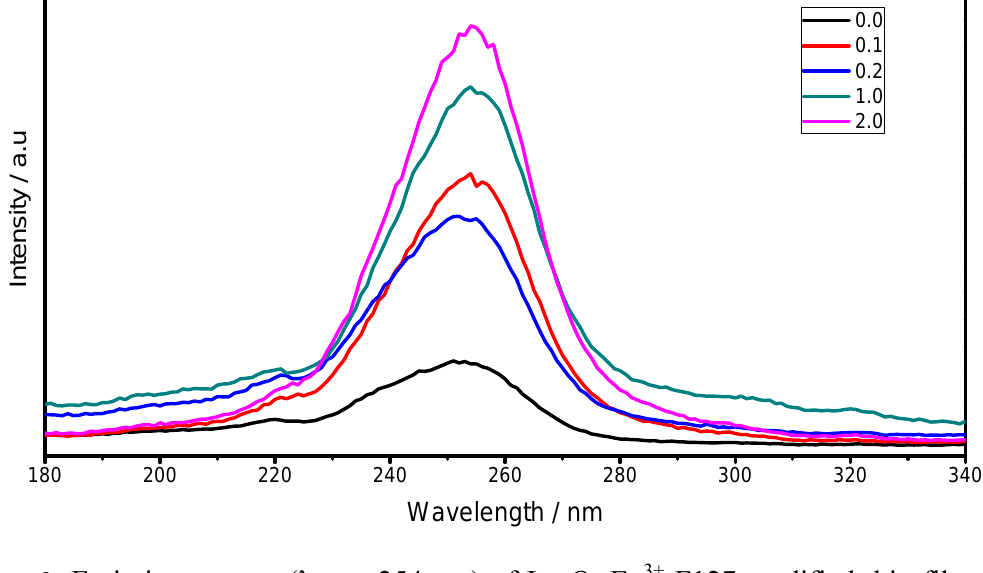
= 612 nm) of Lu O :Eu 3+ F127 modified thin films as a em 2 3